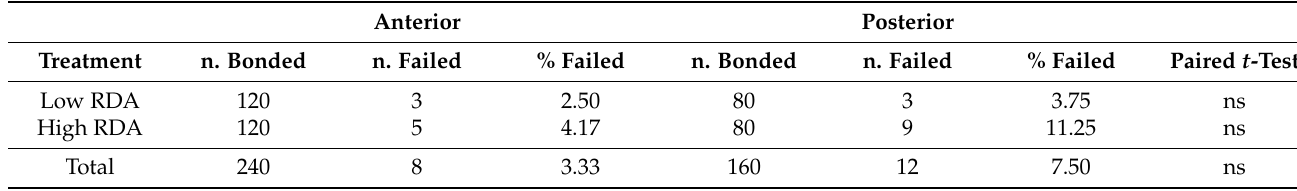
Table 7. Failure rates of brackets per site (anterior and posterior).